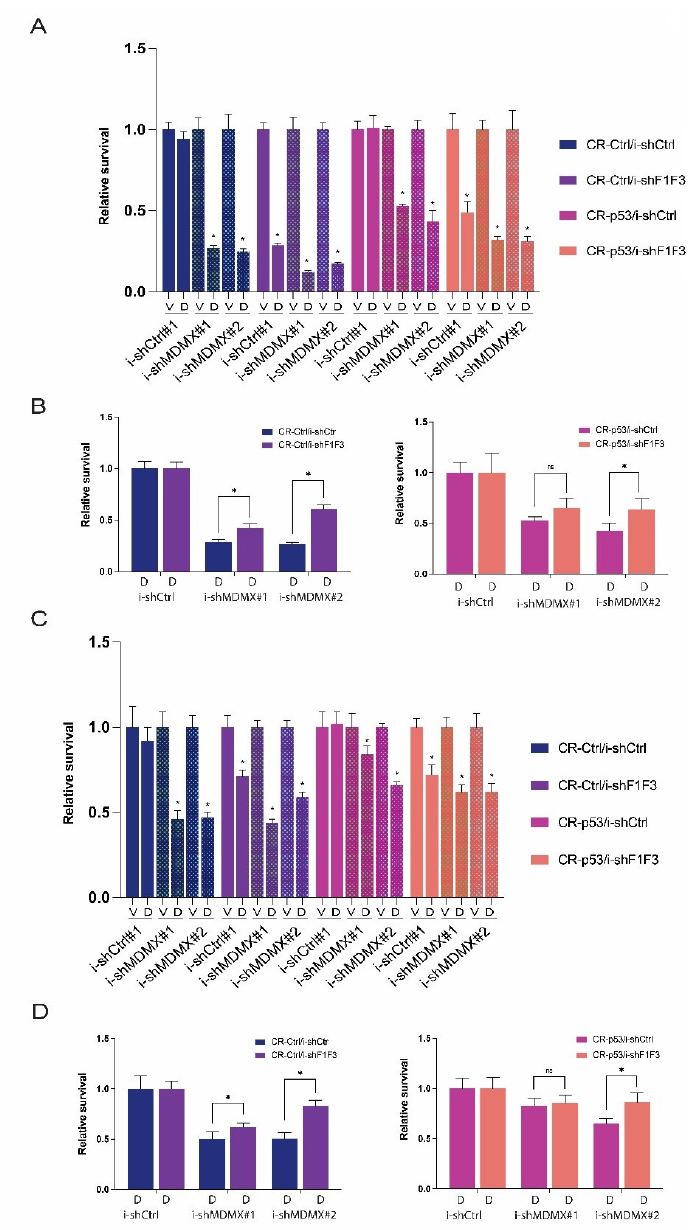
Figure 4. MDMX stimulates growth of UM cell lines MEL202 via attenuation of p53 and FOXO activity. ( A ) Indicated MEL202-derived cell lines (CR-Ctrl and CR-p53; i-shCtrl or i-shFOXO) either containing an i-shCtrl or two distinct i-shMDMX shRNA constructs, were treated with doxycycline (D; 10 ng/mL) for 5 days. Relative survival of the cell lines, each normalized to Vehicle (V)-treated samples. Significant alterations ( p < 0.05) in cell survival are indicated with *. ( B ) Relative survival of the indicated cell lines but now normalized to i-shCtrl + Doxycycline to determine the effect of MDMX depletion in i-shCtrl versus i-shFOXO cells. Significant alterations ( p < 0.05) in cell survival are indicated with *. ( C ) Indicated MEL202-derived cell lines (CR-Ctrl and CR-p53; i-shCtrl or i-shFOXO) either containing and i-shCtrl or i-shMDMX shRNA construct were treated with doxycycline (D; 10 ng/mL) for 3 days. Relative survival of the cell lines all normalized to Vehicle (V)-treated samples. Significant alterations ( p < 0.05) in cell survival are indicated with *. ( D ) Relative survival of the indicated cell lines but now normalized to i-shCtrl + Doxycycline to determine the effect of MDMX depletion in i-shCtrl versus i-shFOXO cells. Significant alterations ( p < 0.05) in cell survival are indicated with